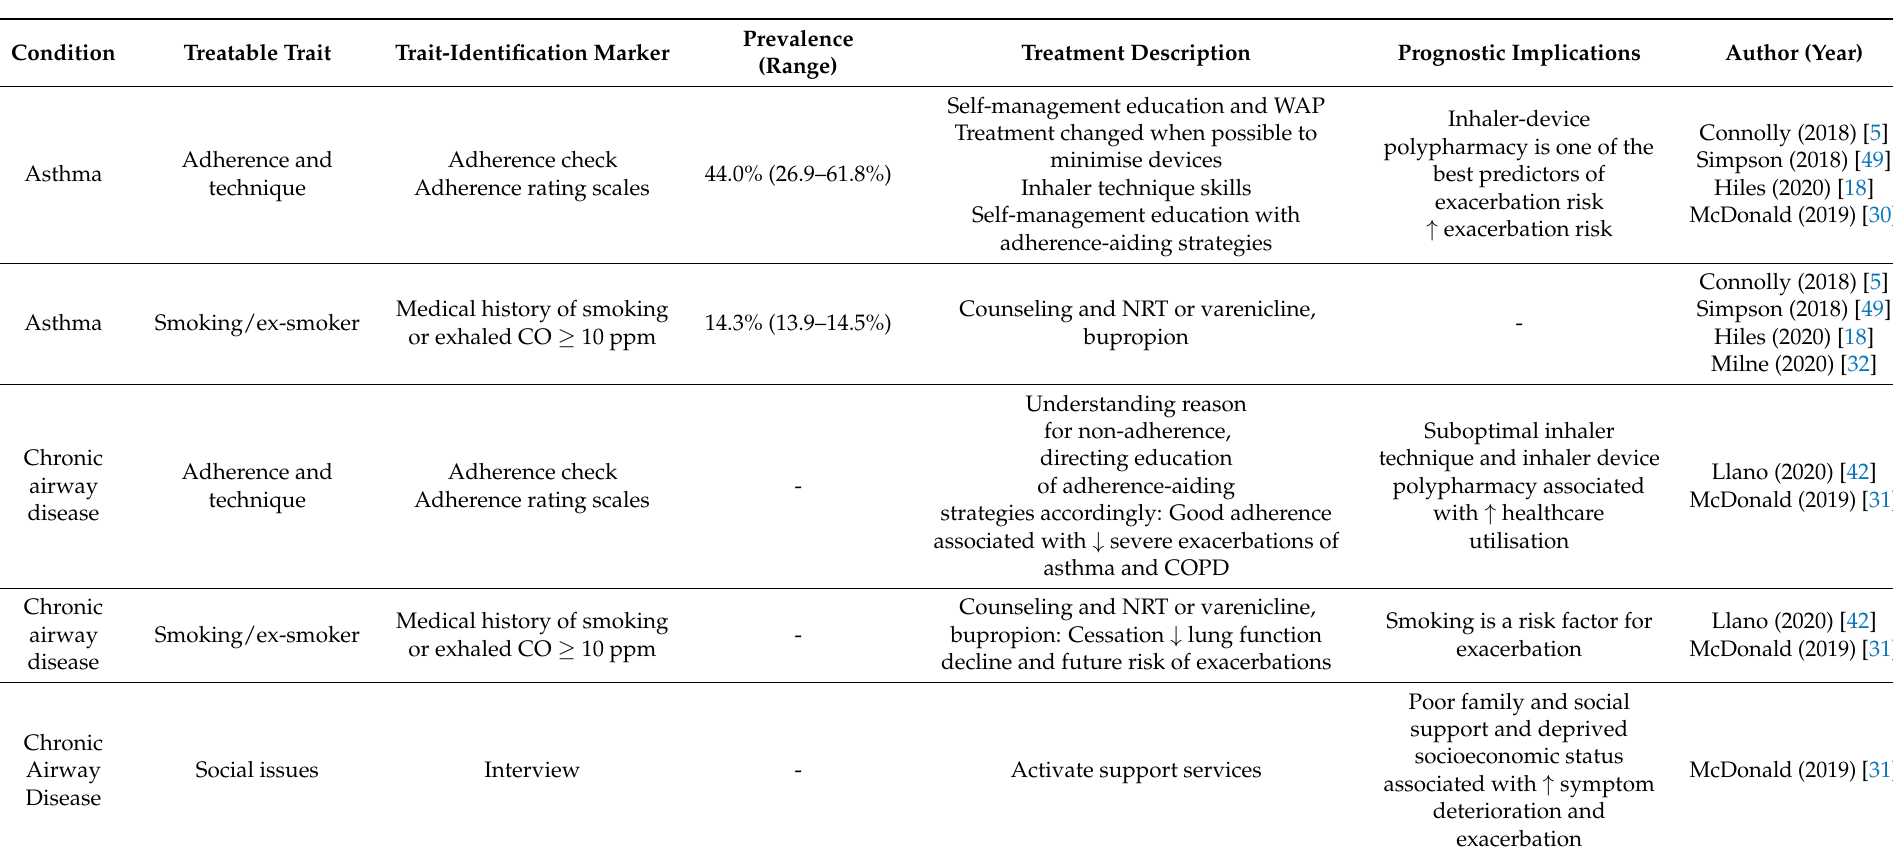
Table 4. Overview of psychosocial treatable